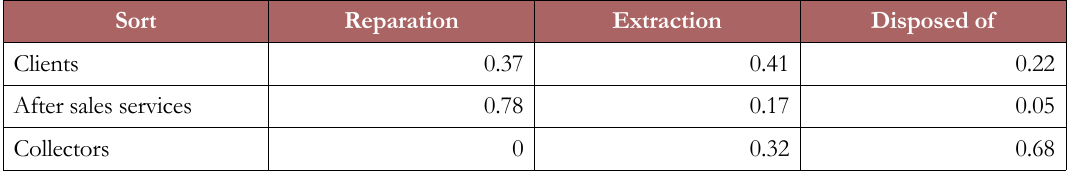
Table 2. Ratio of each returned product’s states depending on the sources